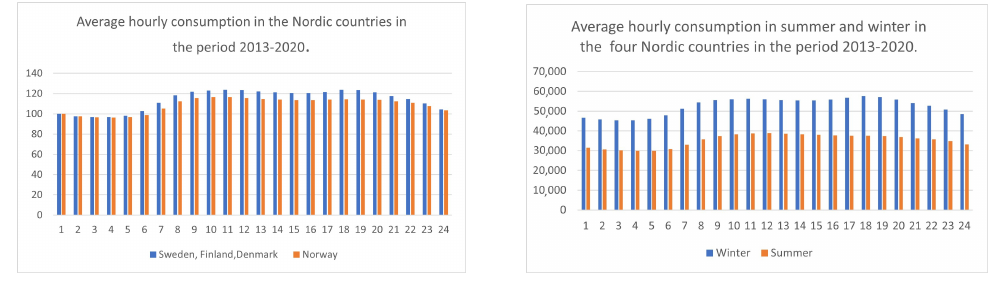
( a ) Norway and other Nordic countries. ( b ) Winter and summer consumption. Figure 4. In figure ( a ), average consumption per hour during the day in Norway and the other Nordic countries compared to consumption between midnight and 0100 in the years 2013–2020 in these countries is shown. Figure ( b ) shows the relative consumption in summer and in winter. Table 5. Average hourly consumption in Norway and the other Nordic countries (Sweden, Finland, and Denmark) in the period of 2013–2020. All figures are seen in relation to consumption from midnight to